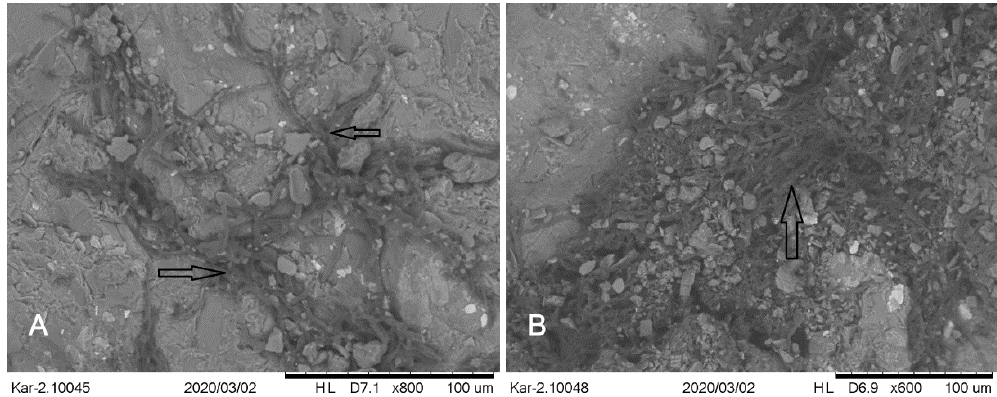
Figure 10. Locations of micromycetes (arrows) on the disintegrated rock surface: ( A ) hyphae of a micromycete in fissures and deepening of the rock surface layer; ( B ) dense interweaving of micromycete hyphae with small fragments of rock on the fungal surface.